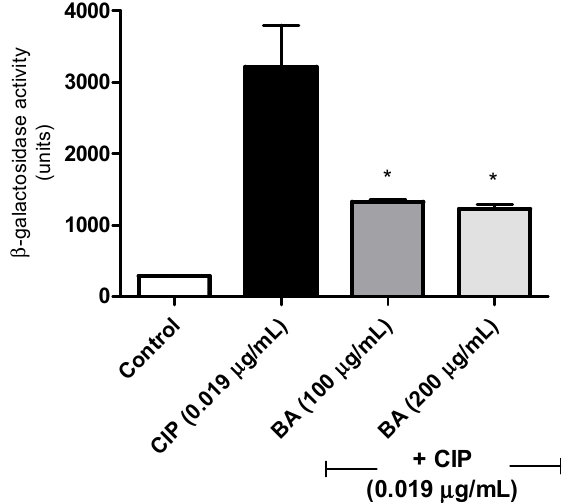
Figure 2. Effect of betulinic acid in the expression of S. aureus recA induced by ciprofloxacin. The strain was incubated with ciprofloxacin (0.019 µg/mL) alone or in combination with betulinic acid (100 or 200 µg/mL). The expression of recA were measured after 3 h, using a derivative S. aureus 8325-4 strain carrying a recA::lacZ fusion. β -galactosidase activity was measured using 2-Nitrophenyl β - D -galactopyranoside (ONPG). CIP—Ciprofloxacin; BA—betulinic acid. * indicates statistical differences related to the ciprofloxacin-treated cells ( p < 0.05).